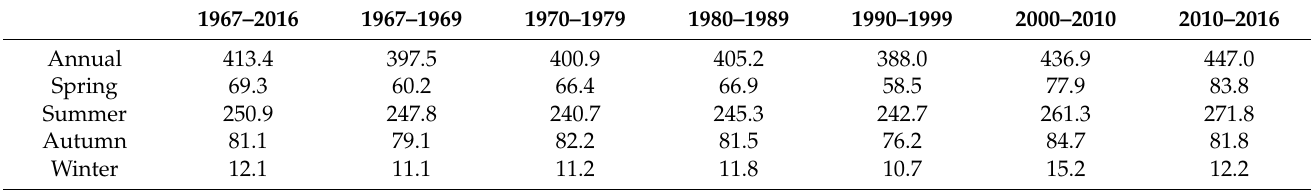
Table 1. The average value of precipitation indifferent ages in the QTP